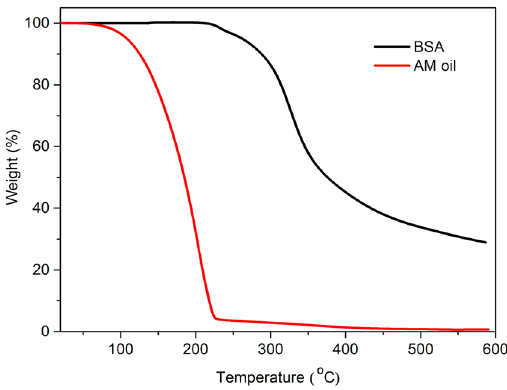
Figure 4: TG curves of BSA and AM.